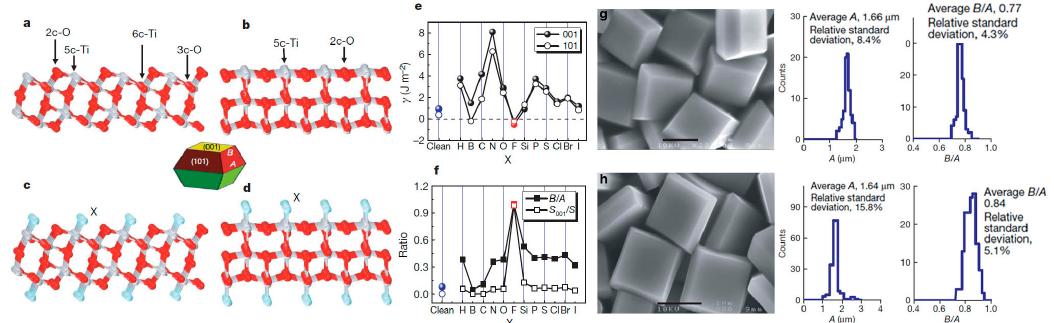
Figure 4. Theoretical calculation guides the modification of surface/interface structures. ( a – f ) Slab models and calculated surface energies of anatase TiO 2 (001) and (101) surfaces. ( a , b ) Unrelaxed, clean (001) and (101) surfaces; ( c , d ) Unrelaxed (001) and (101) surfaces surrounded by adsorbate X atoms; ( e ) Calculated energies of the (001) and (101) surfaces surrounded by X atoms; and, ( f ) Plots of the optimized value of B/A and percentage of {001} facets for anatase single crystals with various adsorbate atoms X . Here, the parameters of A and B are the lengths of the side of the bipyramid and the side of the square {001} “truncation” facets (see the geometric model). The value of B/A describes the area ratio of reactive {001} facets to the total surface. ( g , h ) SEM images and statistical data for the size and truncation degree of anatase single crystals (Reproduced with permission from [43], Copyright Nature Publishing Group, 2008).